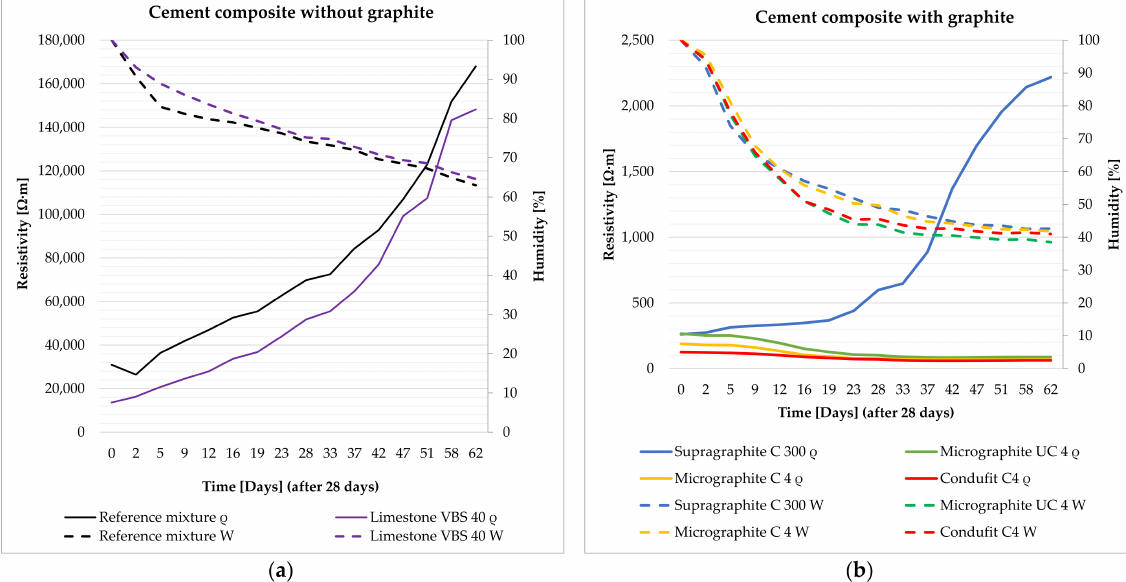
Figure 9. The effect of humidity on the resistivity of silicate composites: ( a ) without the content of graphite; ( b ) with the content of